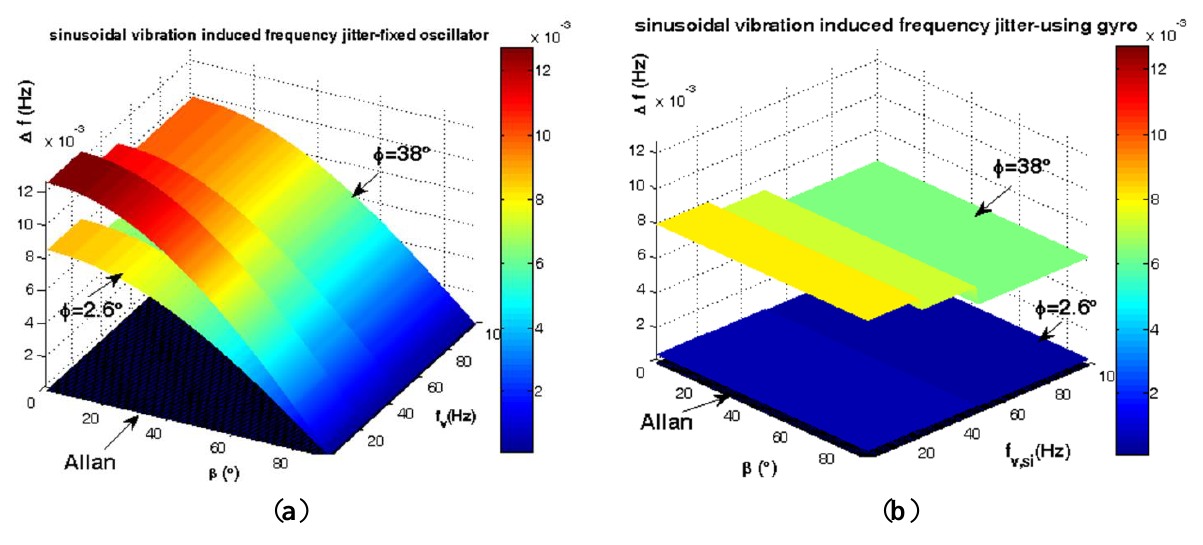
Figure 18. Comparison between sinusoidal vibrations-induced frequency jitter and Allan deviation safety margin. ( a ) Fixed oscillator; ( b ) Gyroscopic